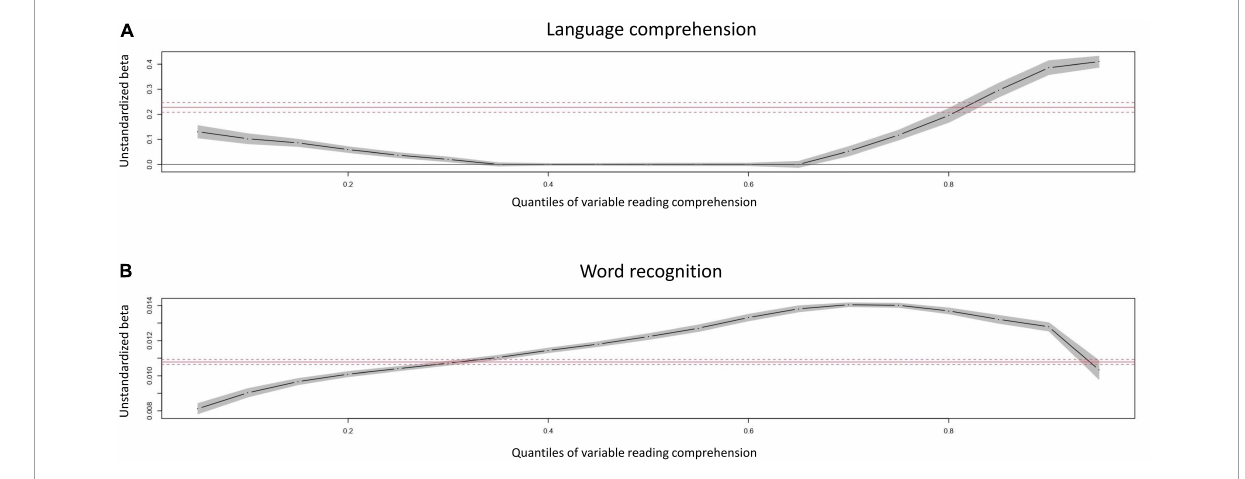
FIGURE1 Quantile regression’s graphical representation (Dependent variable: Reading Comprehension).